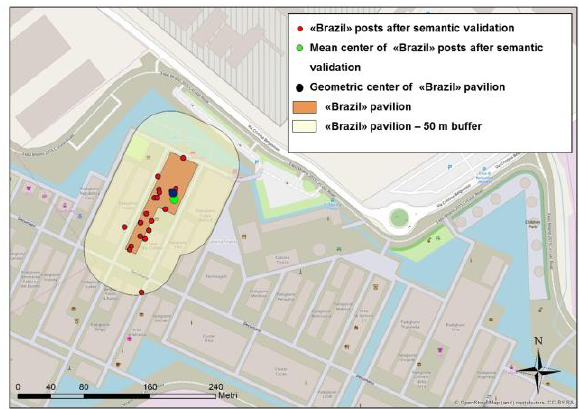
Figure 8. Example of results of the check of the validation procedure (case: Brazil pavilion); black dot represents the geometric center of Brazil pavilion polygon; green dot represents the mean center of validated